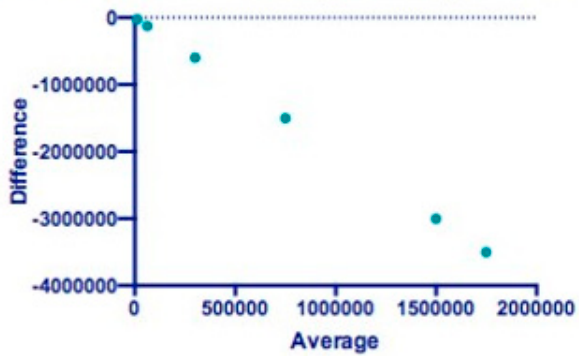
Figure 2. Bland–Altman Plot of colony count by two methods.